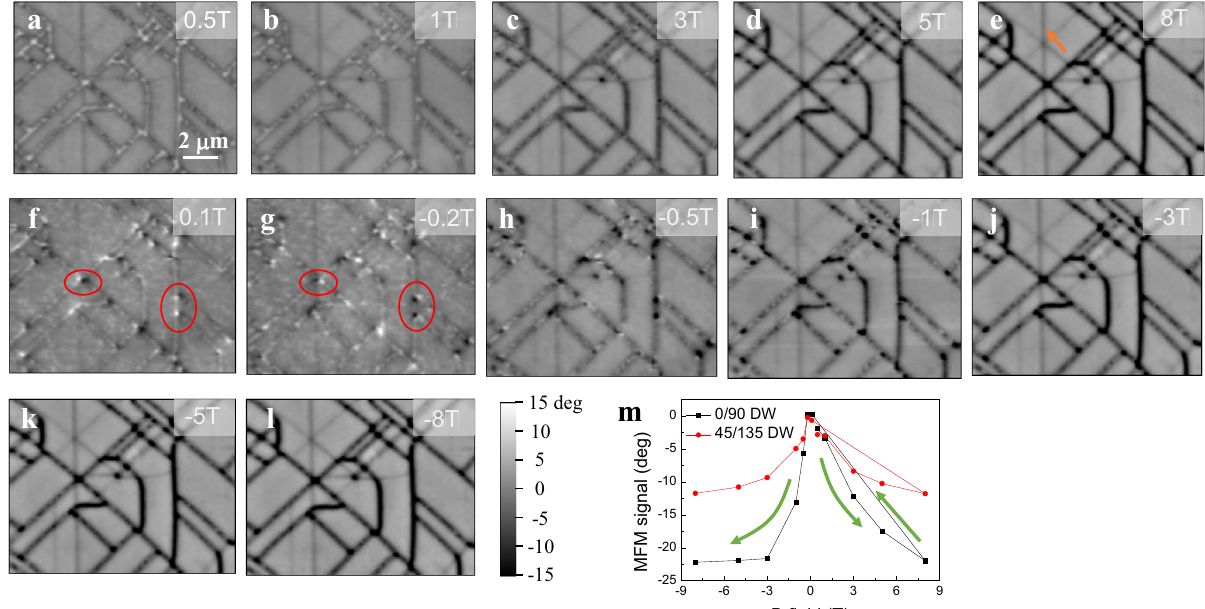
Fig. 2 | Magnetic force microscopy (MFM) characterization of nanoscale net- work of electronic phase separated (EPS) domain. a – l Sequential MFM images takenat12Kunderdifferentmagnetic fi